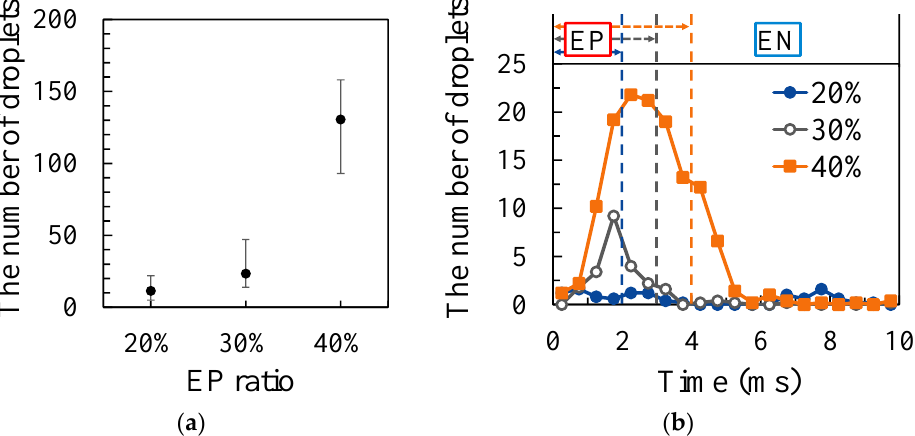
Figure 9. The number and timing of droplet ejection for different EP ratios: ( a ) number of droplets; ( b ) timing of droplet ejections.